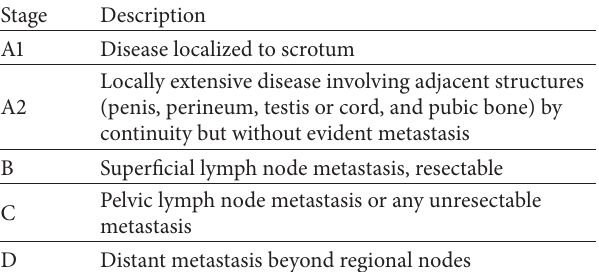
Table 1: Lowe’s staging of scrotal